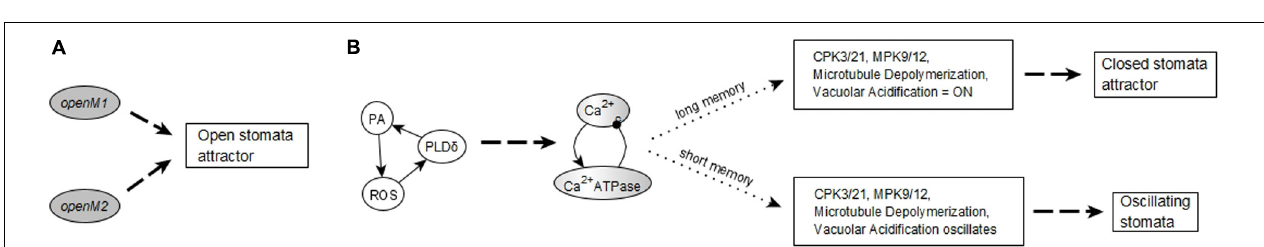
FIGURE 8 | Succession diagram for Model1 with short term memory. (A) Stable motif succession diagram in the absence of ABA and any other closure-inducing signal. Regardless of the duration of the memory, this case always leads to an open stomata attractor. (B) Motif succession diagram in the presence of ABA. The system can reach two different attractors depending on whether the memory duration is large enough. When the memory duration is large enough, sustained Ca 2 + c oscillations can sustain the ON state of the nodes CPK3/21, MPK9/12, Microtubule Depolymerization, and Vacuolar Acidification. With small memory duration these nodes oscillate instead of stabilizing; as a result, the node corresponding to stomatal closure also oscillates. See Supplementary Text S3 for details on the sufficient memory durations and Supplementary Table S4 for these attractors. The dashed edges denote logic succession with certainty while the dotted edges denote the variant outcomes depending on the memory